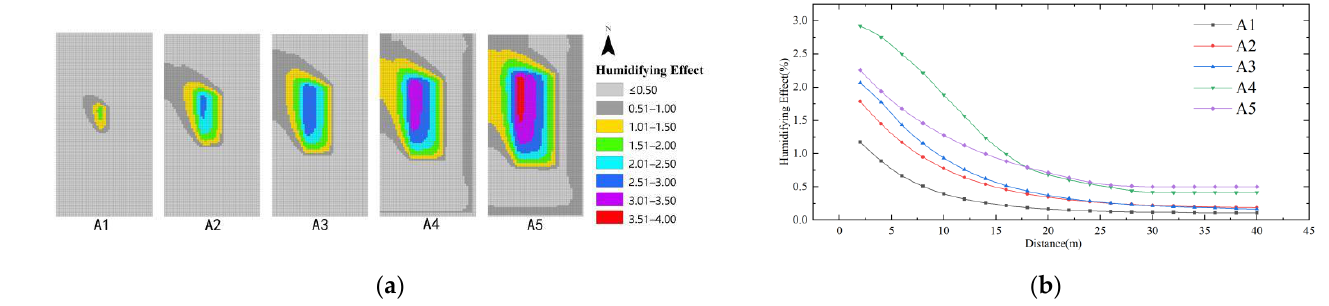
Figure 15. Humidifying effect of water body area index: ( a ) Impact distribution map; ( b ) Impacts with distance.